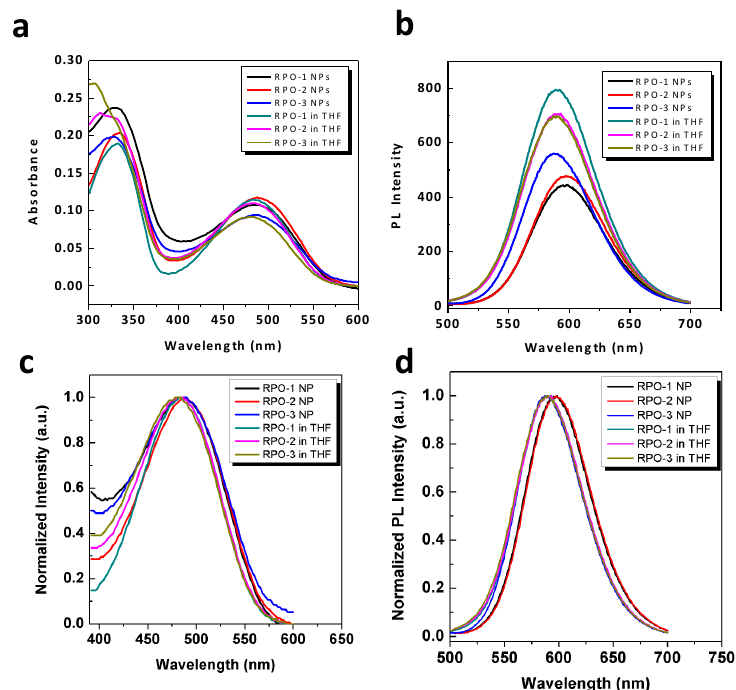
Figure 2. ( a ) Ultraviolet–visible (UV–vis) absorption spectra and ( b ) emission spectra of three polymers at the same concentration in THF and water. ( c ) Normalized UV–vis absorption spectra and ( d ) emission spectra.